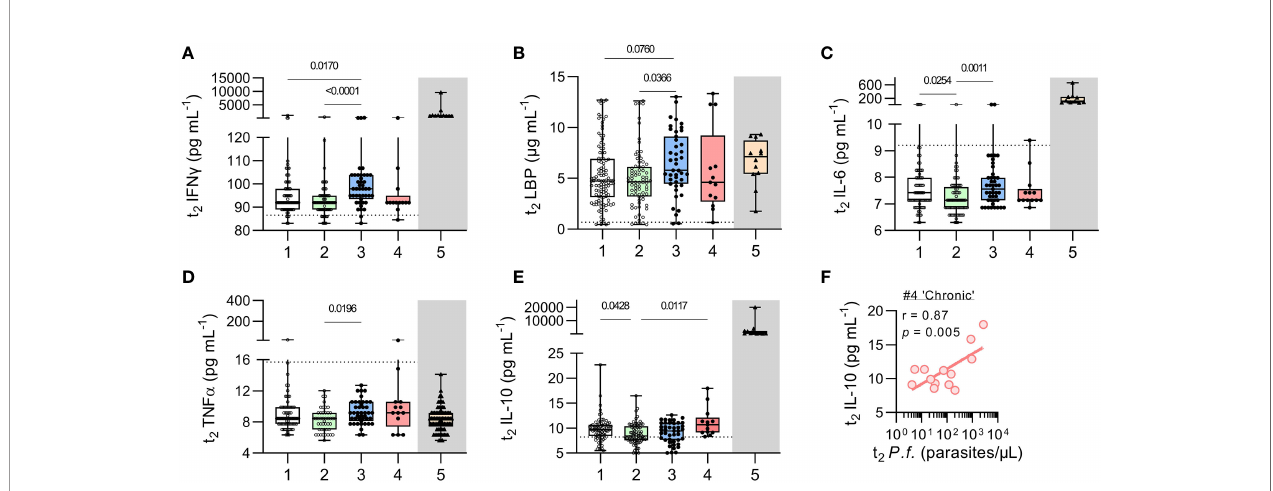
FIGURE 6 | In fl ammatory cytokines in uninfected children and children with resolved or persistent P. falciparum infections. Concentrations of soluble proteins in plasma measured by Luminex multiplex bead-based assay (Invitrogen) for (A) IFN g , and (B) LPS binding protein (LBP), (C) IL-6, (D) TNF a , and (E) IL-10. As a reference point (grey box), protein concentrations for 12 Gambian children with acute, clinical malaria (11, 12) are shown (with patient demographics in Table S1 ). Dotted lines represent the ‘ lower limit of quanti fi cation ’ (LLOQ, Table S2 ). Data shown as box plots with min/max whiskers where dots represent each participant. Signi fi cant p values shown, calculated using a Kruskal-Wallis rank sum test followed by a post-hoc Dunn ’ s test with Bonferroni adjustment for multiple comparisons. (F) Given the increase in IL-10 observed in children with chronic malaria parasite infection, correlation analysis of current (t 2 ) parasite infection with plasma IL-10 was performed. Pearson ’ s correlation (r) shown with fi tted regression line and p value from a permutation test. Group IDs: #1 ‘ controls ’ , #2 ‘ anaemic ’ , #3 ‘ resolved ’ , #4 ‘ chronic ’ , & #5 ‘ clinical malaria ’